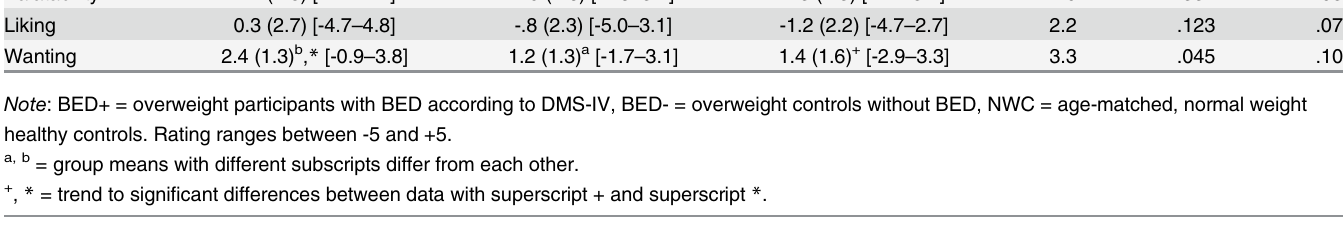
Table 4. Means (SD) [range] of self-reported valuation regarding food stimuli. Food stimuli BED+ (n = 16) BED- (n = 23) Palatability Wanting Note : BED+ = overweight participants with BED according to DMS-IV, BED- = overweight controls without BED, NWC = age-matched, normal weight healthy controls. Rating ranges between -5 and +5. a, b = group means with different subscripts differ from each other. + , * = trend to signi fi cant differences between data with superscript + and superscript *